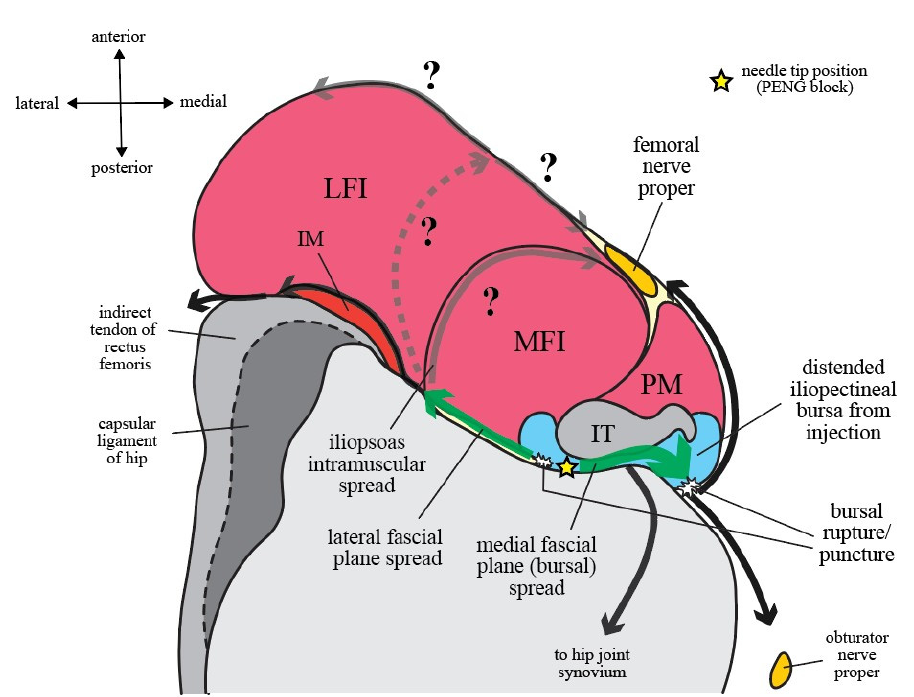
Figure 7. The injectate spread behavior after 20 mL pericapsular nerve group (PENG) block: Solid arrowed lines represent the routes of spread that have been observed in the cadaveric or clinical studies included in this review, while the faded arrowed lines represent theoretical routes of spread that await further evidence. The dashed arrowed line marks the superficial spread via the muscular iliopsoas plane (IP) as in Figure 4. Medial fascial plane (bursal) spread is the most commonly observed route of spread under ultrasound after PENG block (Table 1). Since Iliopectineal bursa lies immediately deep to iliopsoas tendon (IT), it can be easily injected during PENG block. As the bursa ruptures from pressure/volume overload or is punctured by the needle tip, both the anteromedial spread along the anterior surface of psoas major (PM) to involve femoral nerve proper and the posteromedial spread to involve either the obturator nerve proper (intrapelvic) or its divisions (extrapelvic) can occur [22,39]. When iliopectineal bursa is injected, intra-articular spread via the bursal-synovium communication can also occur [38]. Lateral fascial plane spread is the second most commonly observed spread route after PENG block (Table 1), and a further continuation of this lateral spread to the gluteus muscles were shown in another cadaveric study [37].